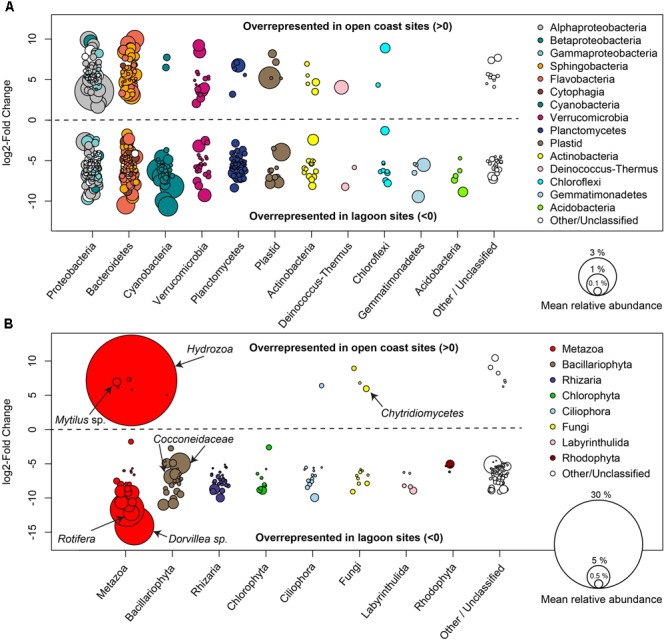
Differential abundance analysis of 16S (A) and 18S (B) rRNA gene sequence variants comparing open coast and lagoon sites. Positive log2 fold-change values indicate a significantly (adjusted p < 0.01) higher abundance in open coast sites, while negative values indicate significantly higher abundances in lagoon sites. The area of each circle representing an individual sequence variant is proportional to the relative abundance of that sequence variant across all samples. Prominent eukaryotic sequence variants are labeled with more detailed taxonomic classification.